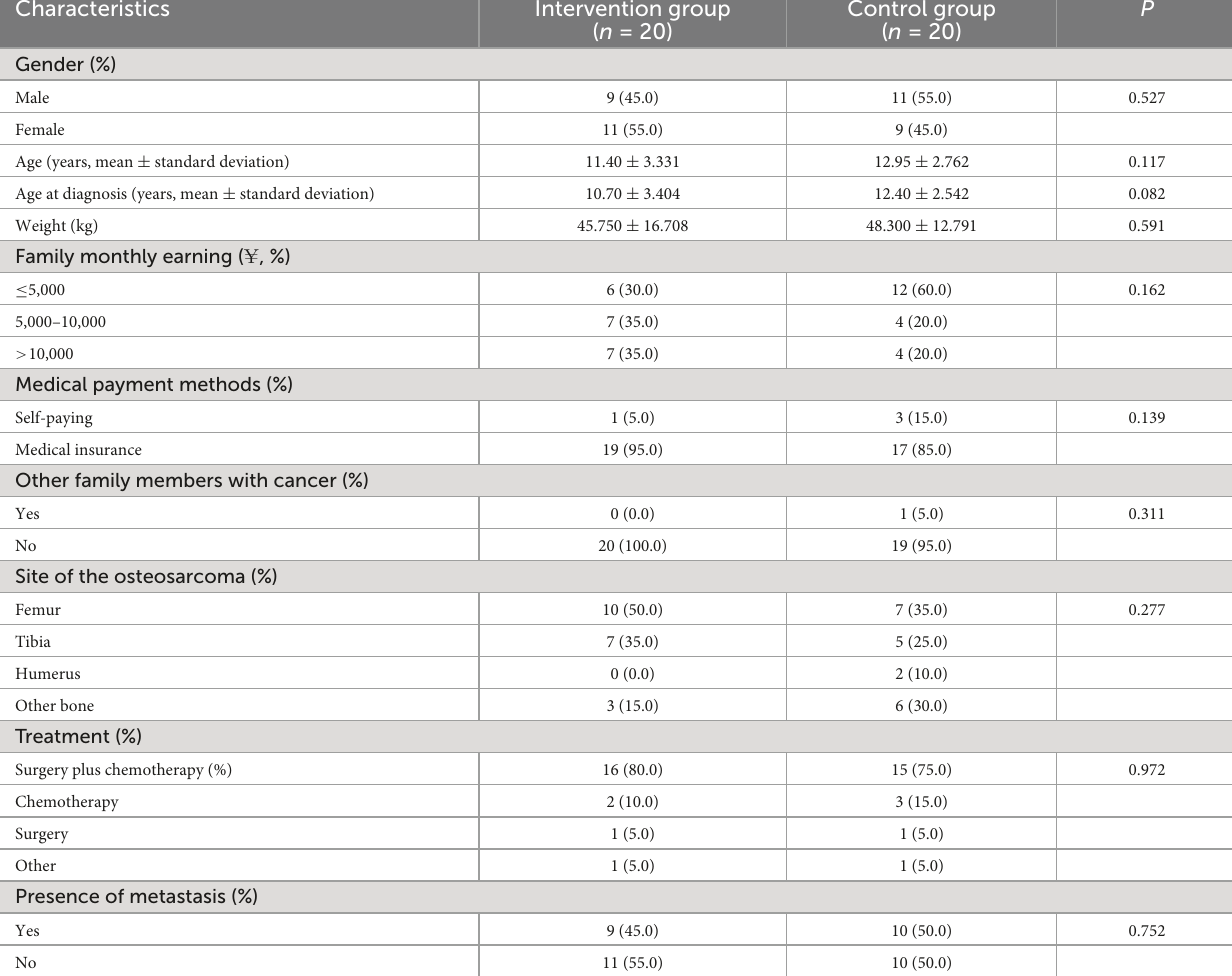
TABLE 2 The basic characteristics of the intervention and control groups. Characteristics Intervention group